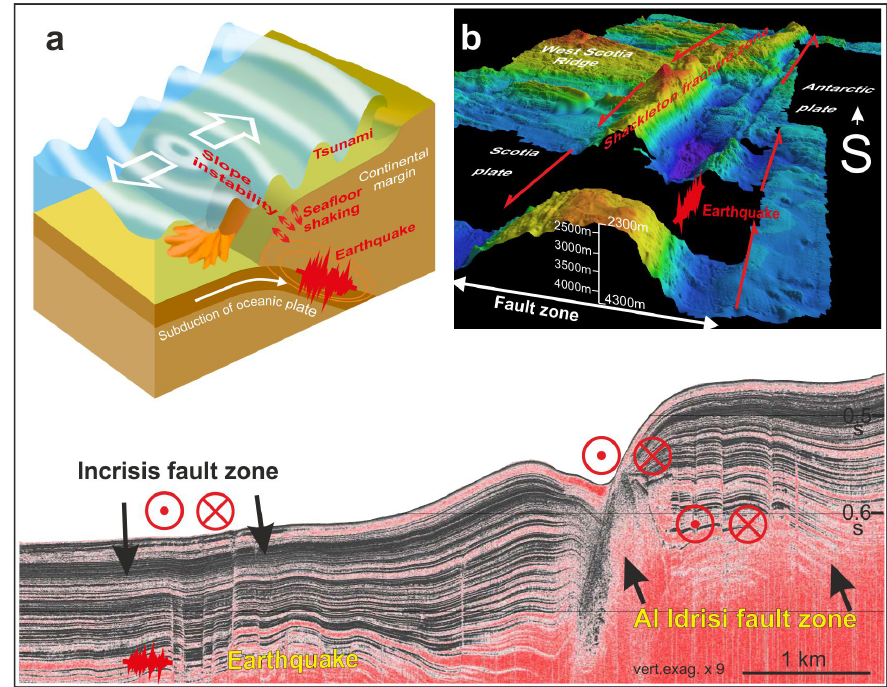
Figure 3. Examples of active seismogenic faults: ( a ) Subduction earthquakes in convergent plate margins have the highest magnitudes and produce seafloor shaking, submarine landslides, and tsunamis; ( b ) oblique-view perspective of the Shackleton fracture zone (Antarctica) that constitutes the transpressive sinistral active margin between the Scotia and Antarctic plates. Bathymetric features are determined by the permanent deformation of the seafloor; more details on this fracture zone can be found in [65,66]; ( c ) high-resolution seismic profile of the Incrisis and Al Idrisi sinistral fault zones in the central Alboran Sea, western Mediterranean. The tectonic activity of the Al Idrisi fault zone, now mostly covered by recent sediments, has been transferred to the new Incrisis fault zone, where the active faults affect the most recent sediments; more details on these fault zones in [29 ).